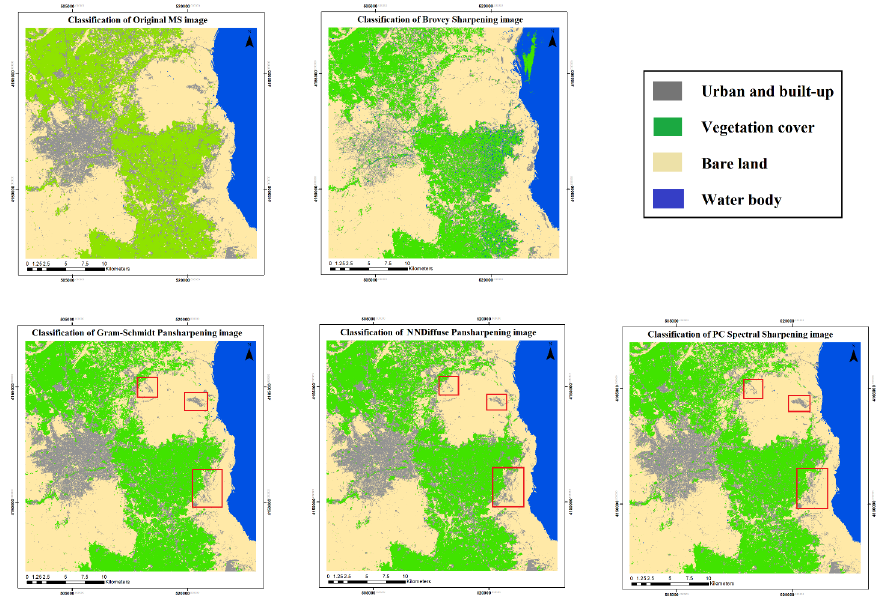
Figure 3. The generated land cover maps using the original and Pan Sharpened